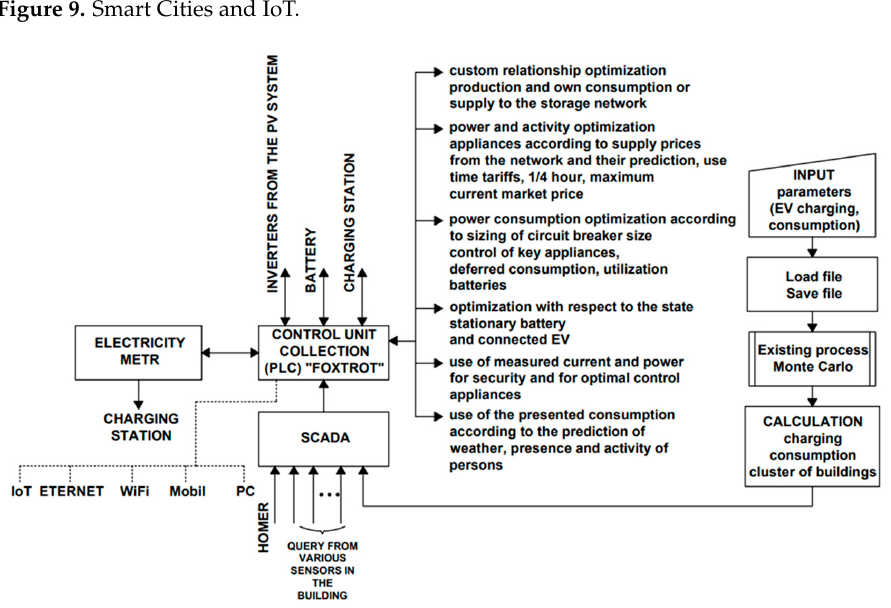
Figure 10. Optimization of energy consumption, IoT and building management system.